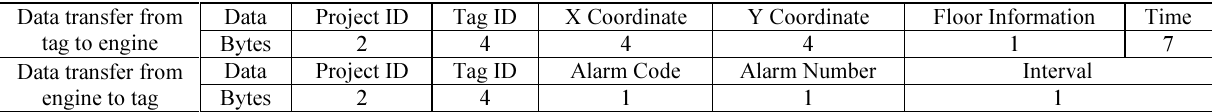
Table 5. Protocol for data transter Data transfer from tag to engine